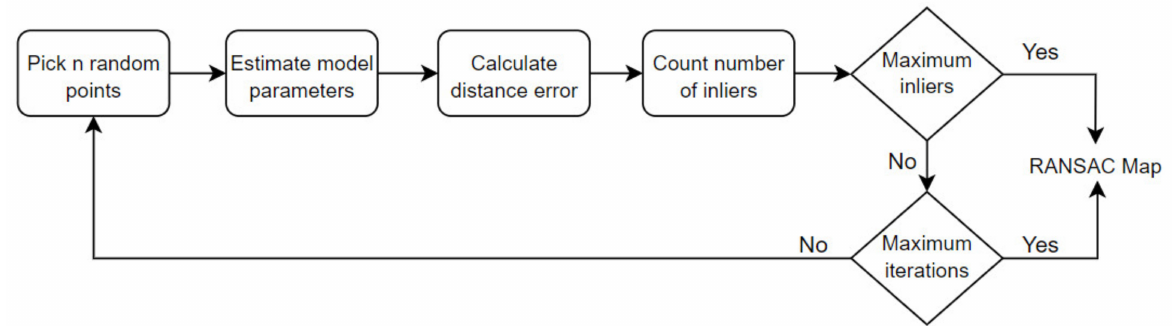
Figure 7. Flow chart of the RANSAC algorithm. A key idea of this approach is to find a mathematical model that covers most of the data. As the amount of soil data is much higher than the plant data, the algorithm finds the model that best fits the soil data. Consequently, the data group that fits the model is found and separated as soil